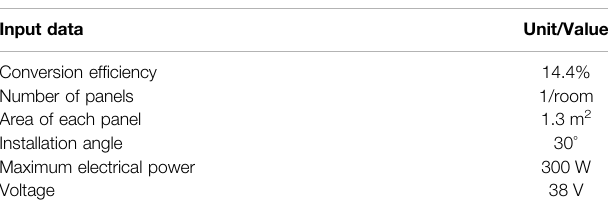
TABLE 5 | Speci fi cations of the